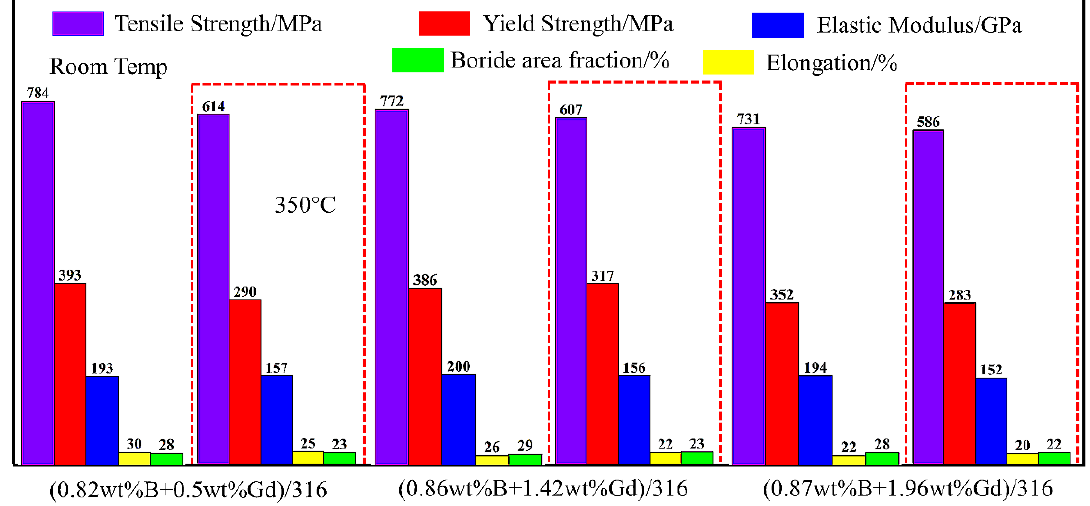
Figure 6. Mechanical properties of 316 stainless steel alloy containing Gd and B [35].